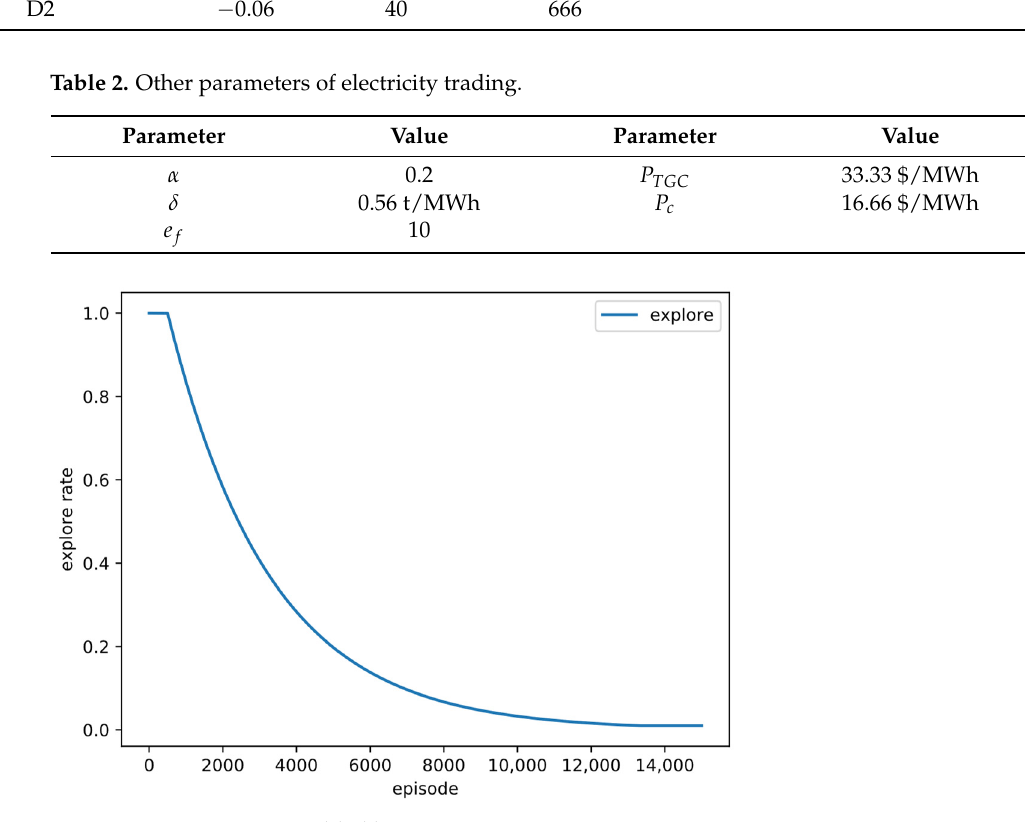
Figure 6. Load varies with market clearing price.